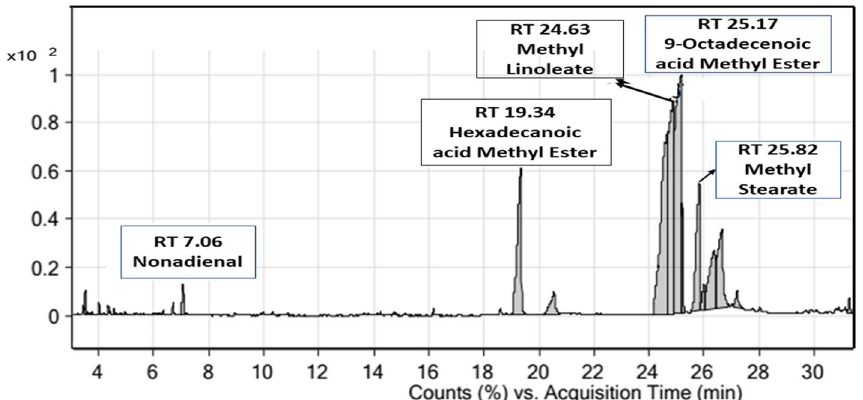
Fig. 12 GC-MS spectra of biodiesel obtained from waste cooking oil using MgO-SnO 2